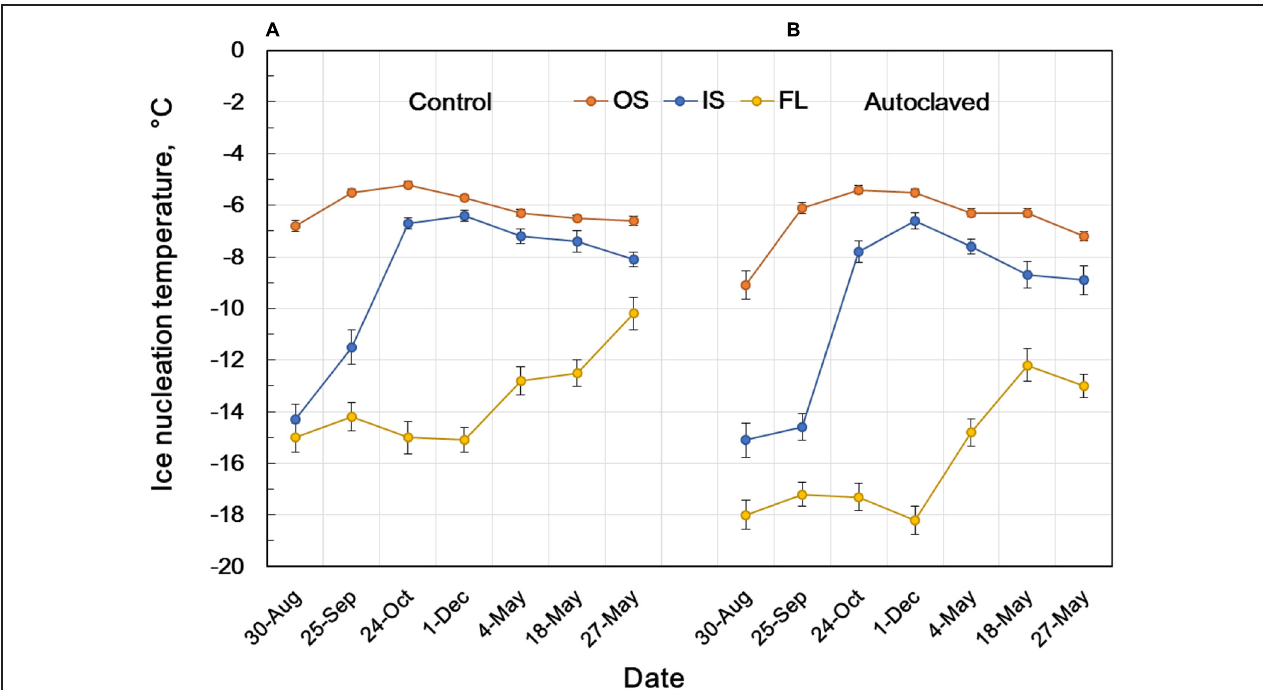
FIGURE 5 | Seasonal changes in the INA of intact flower bud parts of R. japonicum (A) and INA after autoclaving and replacement of water (B) showing the stability of INA at 121 ◦ C for 15 min. INA was determined as the 50% ice nucleation temperature (median INT) using the test tube INA assay as shown in Figure 4 . OS, outer scale; IS, inner scale; FL, floret. The data are mean ± SE ( n = 3).